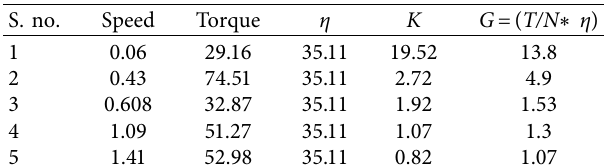
Table 4: Determination of the calibration constant K and G for the various